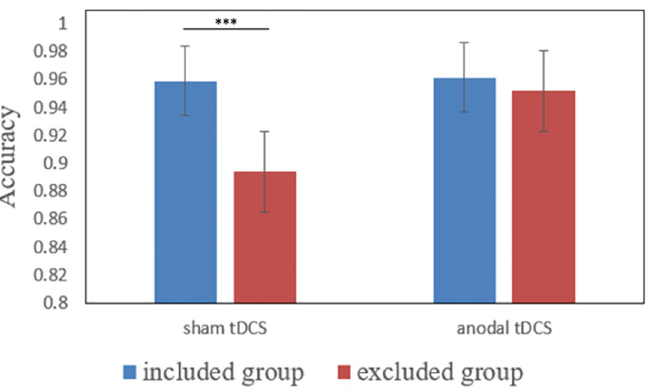
Fig 3. The accuracy of 2-back task for excluded and included participants receiving anodal or sham stimulation. Error bars represent SEMs. *** p < 0.001.